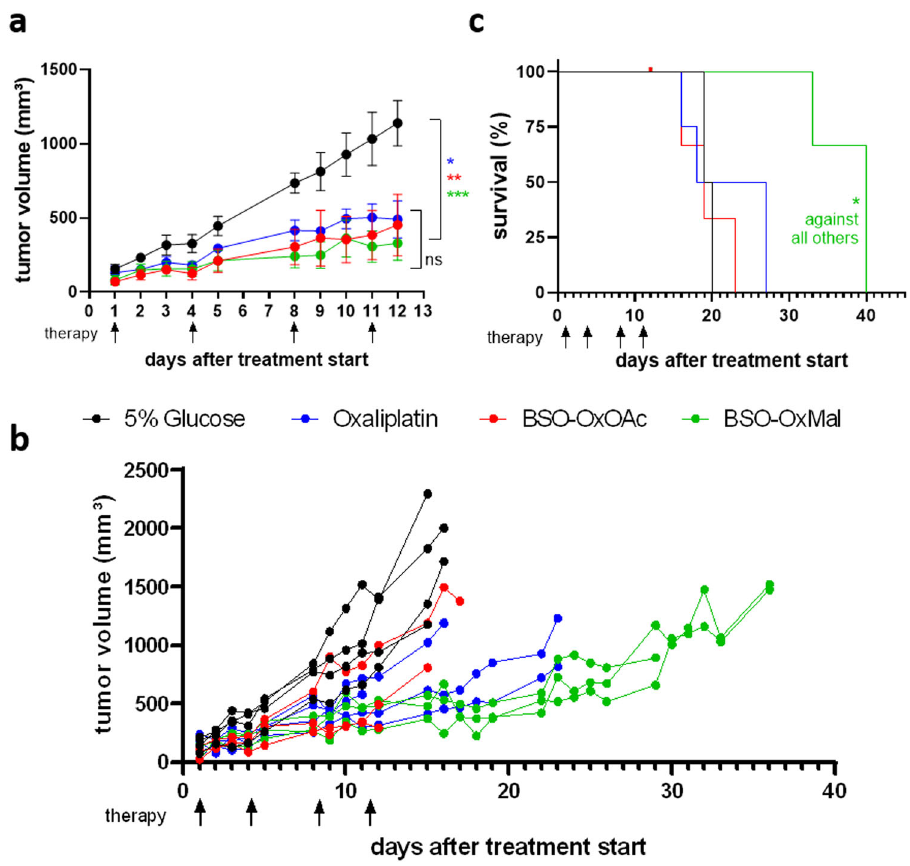
Fig. 8 In vivo anticancer activity of BSO-OxMal and BSO-OxOAc compared to oxaliplatin. Mice bearing CT26 allografts ( n = 4 per group) were treated twice a week for two weeks (black arrows) with equimolar concentrations of BSO-OxMal (23.5mg/kg), BSO-OxOAc (19.1 mg/kg) or oxaliplatin (9mg/kg). Mean ± SEM (standard error of mean) ( a ) and individual ( b ) tumor volumes were assessed at the indicated time points by caliper measurements (maximal tumor growth inhibition of 61.2%, 51.3% and 51.3% at day 11, for BSO-OxMal , BSO-OxOAc and oxaliplatin respectively; tumor doubling time extended by 1.8-fold, 1.2-fold, and 1.3-fold, respectively). ( c ) Overall survival of mice based on FELASA guidelines was analyzed by Kaplan Meier curves.